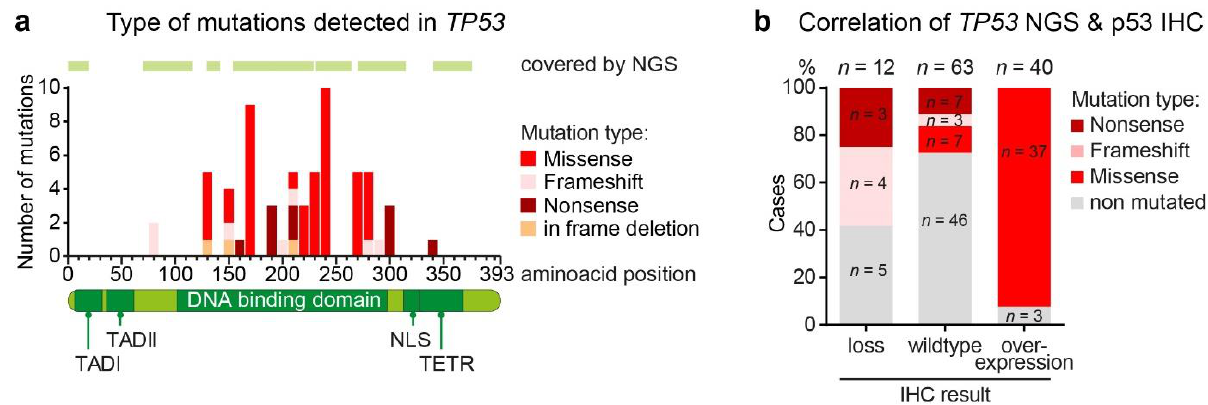
Figure 2. Genetic and immunohistochemical evaluation of TP53 and p53 in GAC, respectively. ( a ) Distribution of the different types of TP53 mutation over the TP53 gene. ( b ) Relationship between aberrant p53 overexpression and the various types of TP53 mutations. TADI, transactivation domain 1; TADII, transactivation domain 2; NLS, nuclear localization signal; TETR, oligomerization domain; IHC, immunohistochemistry; NGS, next-generation sequencing.